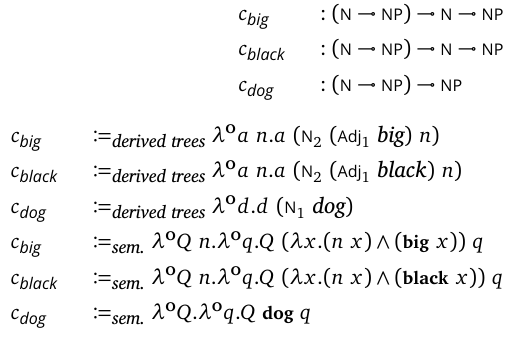
derivations additional constants